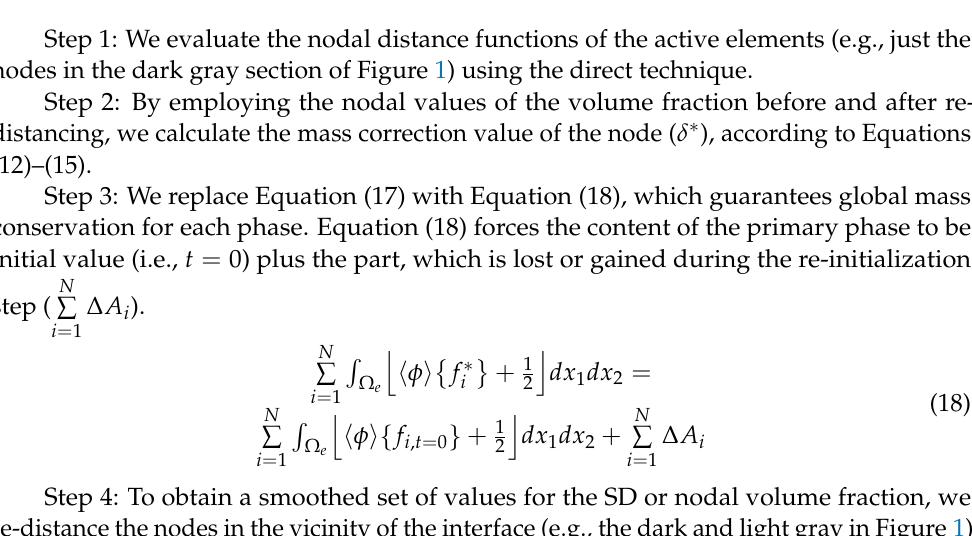
Figure 5. Five revolutions of a circle using a 50 × 50 structured mesh, using the Mut method ( a ) An original circle before (dashed line) and after five revolutions (solid line). The normal vectors are shown after rotation, ( b ) The percentage of curvature deviation (solid line) and mass change (dashed line).